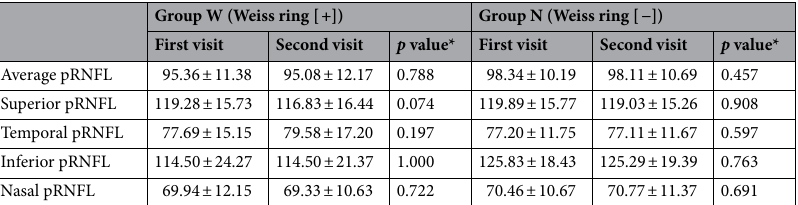
Table 3. Comparisons of average and sectoral peripapillary retinal nerve fiber layer (pRNFL) thickness measurements at the first and second visits in groups W and N. Data are presented as the mean ± standard deviation. * p value for difference in RNFL measurements between the first and second visits using the paired t -test.